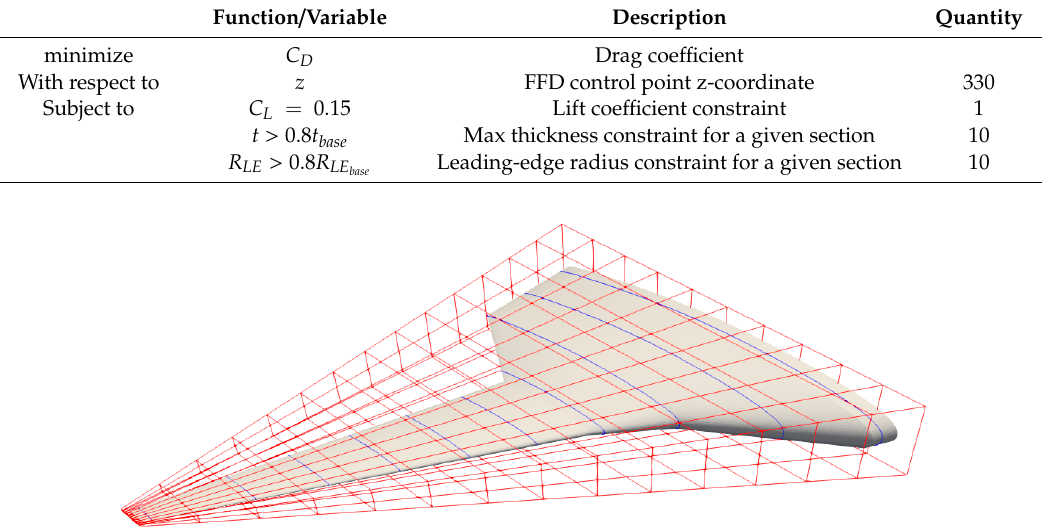
Figure 10. Free-Form Deformation (FFD) Box (red) and control sections (blue) of the SE²A-LR aircraft geometry.